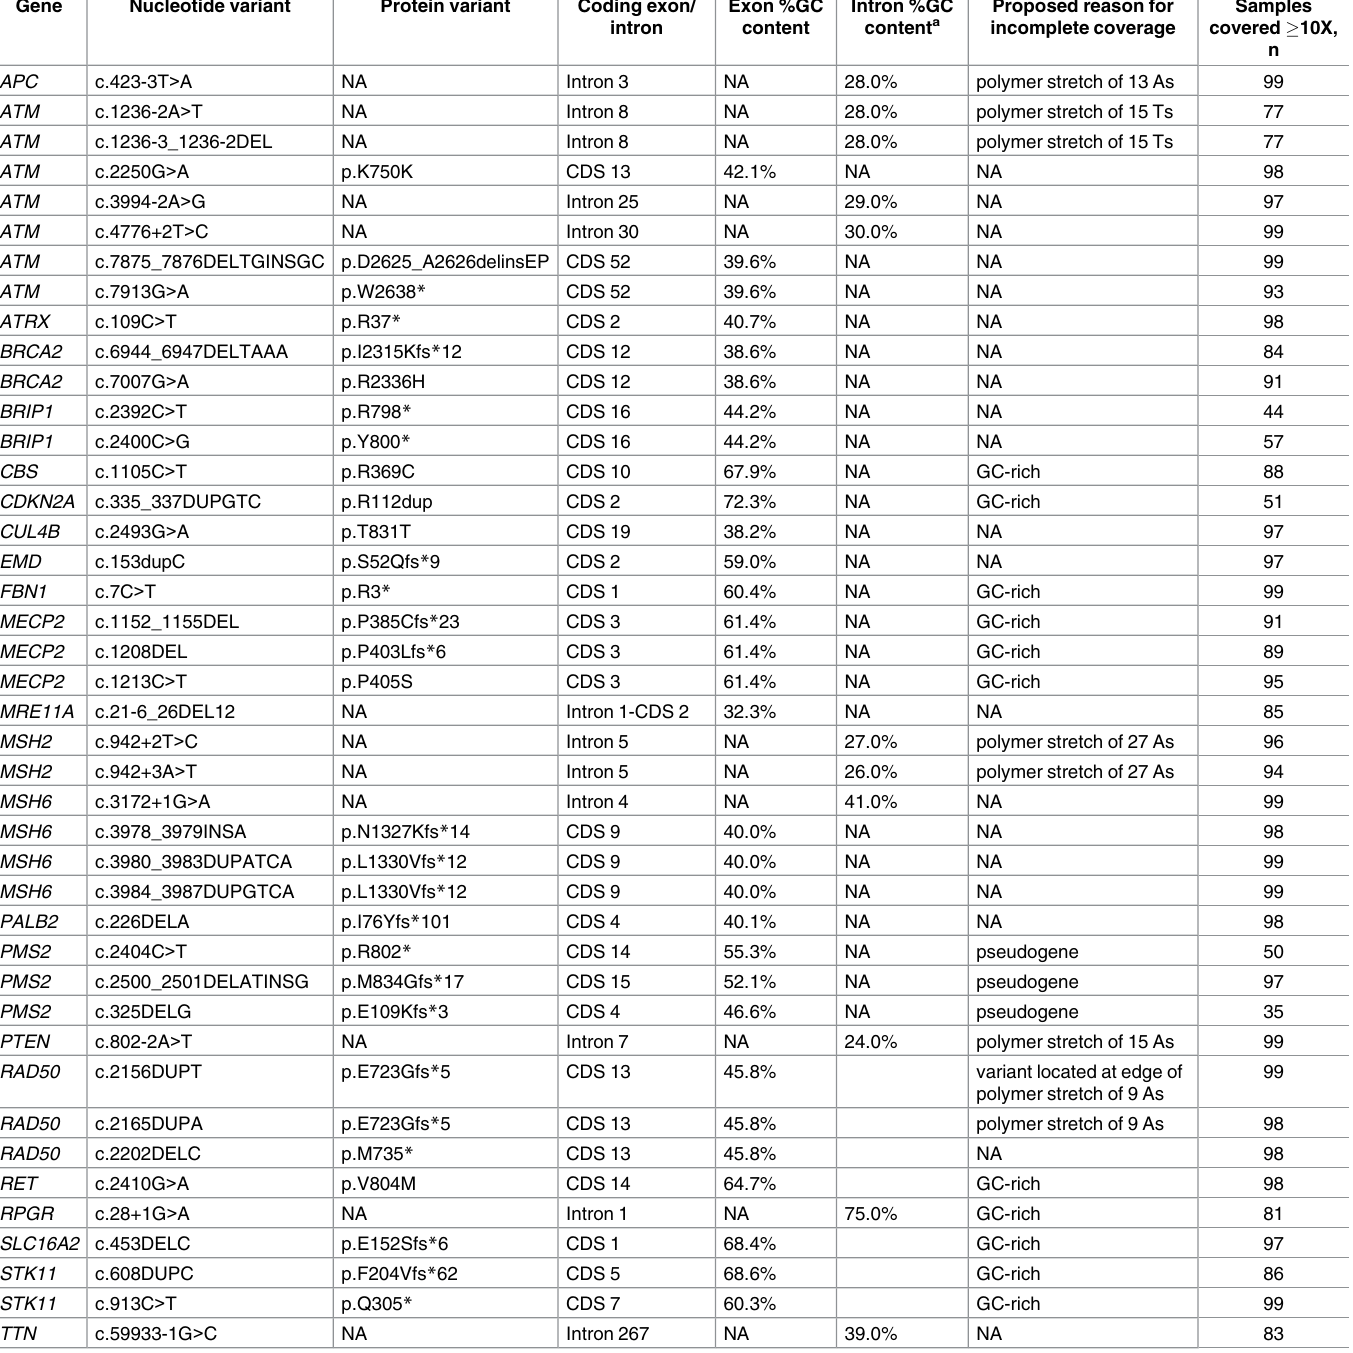
Table 2. Pathogenic variant positions not covered across all 100 WES samples.